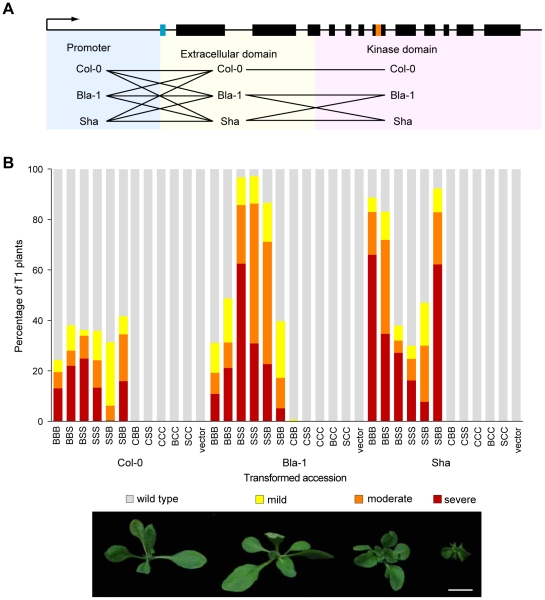
Contribution of both the OAK promoter and extracellular domain to outgrowths.(a) Overview of domain swaps. (b) Phenotypic distribution of T1 plants (n≥90). Three-letter code indicates composition of chimeras. E.g., BBS, promoter and extracellular domain from Bla-1, kinase domain from Sha. Examples of phenotypic classes are shown at the bottom: mild (outgrowths, but otherwise normal leaves), moderate (outgrowths, shortened petioles, mild leaf twisting, normal lamina size) or severe (stunted plants, petioles almost absent, reduced lamina surface, seed rarely obtained). Scale bar = 1 cm.